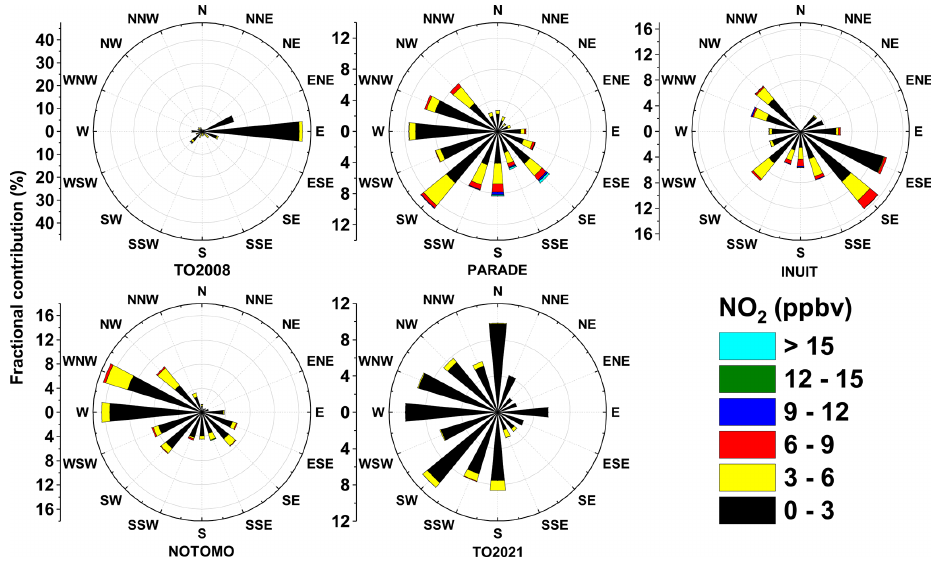
Figure 11. Wind roses indicating the dependence of NO 2 mixing ratio on the wind direction during TO2008, PARADE, INUIT, NO- TOMO, and TO2021. Wind directions were provided by HLNUG for TO2008 and NOTOMO, by a weather station for PARADE and INUIT (Drewnick et al., 2012), and by the German Meteorological Service (DWD) for